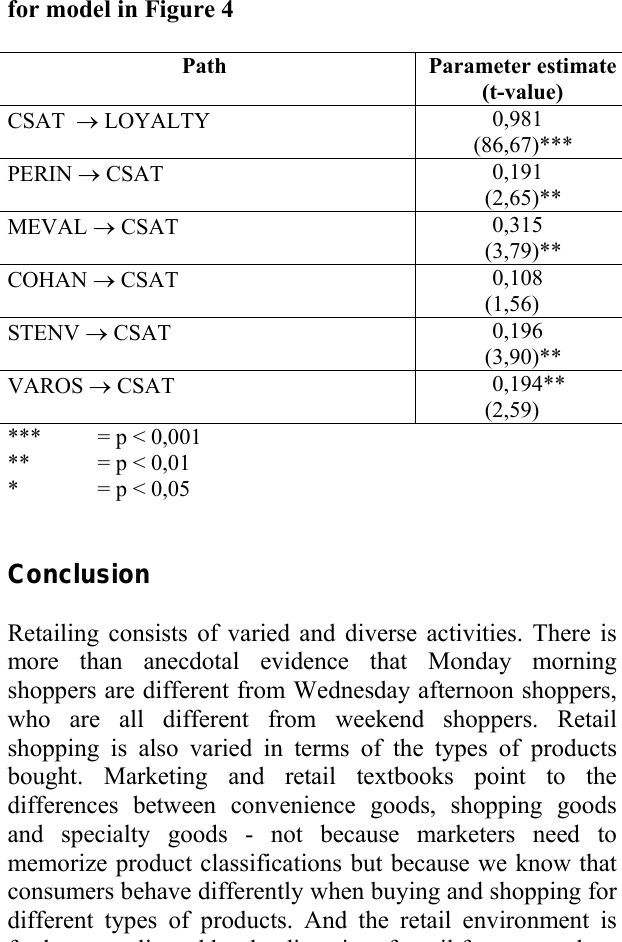
Table 15: Nomological assessment: Parameter estimates for model in Figure